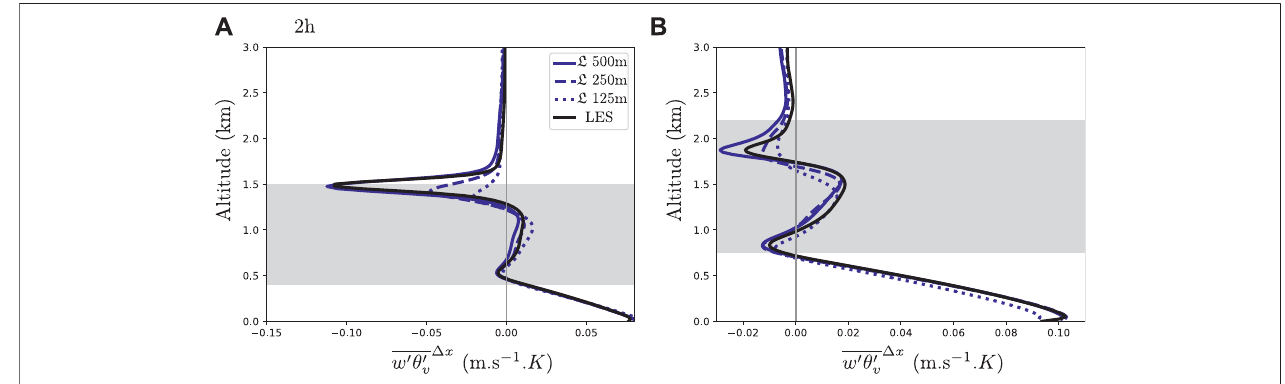
FIGURE11| Verticalpro fi lesoftotal w ′ θ ′ v fromLES(solidline)and L (dashedlines)at125,250,500 mgridspacingat2 h (A) and12 h( B ).Thegrayarearepresents the cloud layer in the LES.